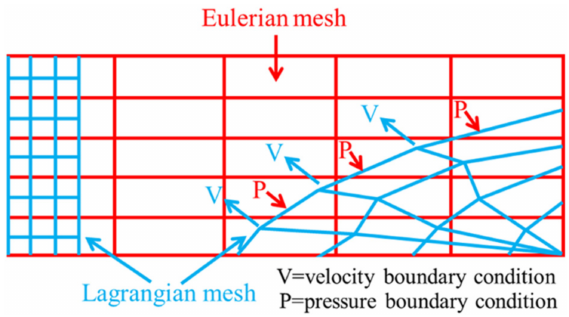
Figure 2. Schematic of the CEL method.